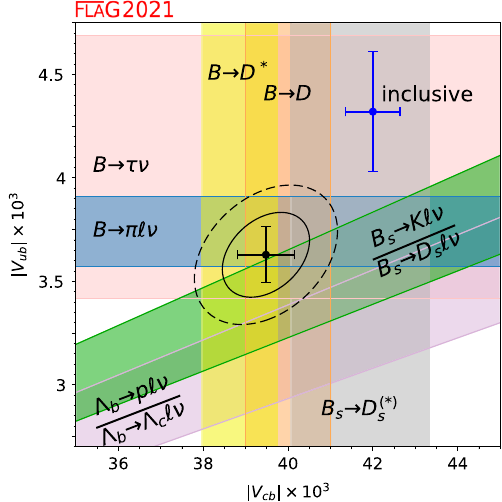
Fig. 38 Summary of | V ub | and | V cb | determinations. The black solid and dashed lines correspond to 68% and 95% C.L. contours, respectively. The result of the global fit (which does not include 0 . 14 ) × 10 − 3 with a p -value of 0.39. The lattice and experimental results that contribute to the various contours are the following. B → π(cid:6)ν : lattice (FNAL/MILC [556] and RBC/UKQCD [557]) and experiment (BaBar [652,653] and Belle [654,655]). B → D (cid:6)ν : lattice (FNAL/MILC [606] and HPQCD [607]) and experiment (BaBar [667] and Belle [666]). B → D ∗ (cid:6)ν : lattice (FNAL/MILC [605]) and experiment (Belle [660]). B → τν : lattice ( f B determinations in Fig 27) and experiment (BaBar [528] and Belle [527]). B s → K (cid:6)ν/ B s → D s (cid:6)ν : lattice (HPQCD [570], RBC/UKQCD [556], FNAL/MILC [573], HPQCD [613]) and experiment (LHCb [669]). (cid:8) b → p (cid:6)ν/(cid:8) b → (cid:8) c (cid:6)ν : lattice (Detmold 15 [516]) and experiment (LHCb [636]). B s → D ∗ s (cid:6)ν/ B s → D s (cid:6)ν : lattice (HPQCD 19 [613] and HPQCD 19B [612]) and experiment (LHCb [614,615]). The inclusive determinations are taken from Refs. [165,261,668] and read ( | V